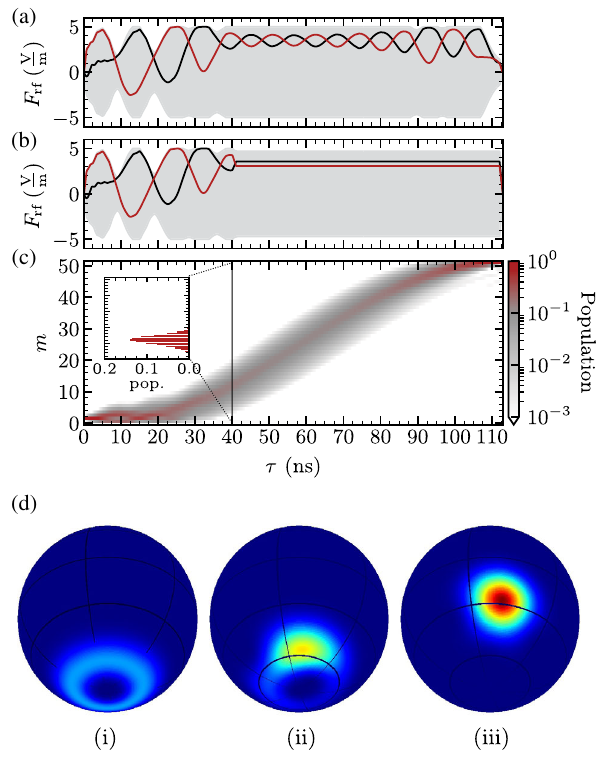
FIG. 4. Optimized circularization pulse. Amplitude of the two quadratures (red and black lines) of the optimized rf pulse (a) before and (b) after postprocessing (flattening of the oscillations that result from the constraint on the spectral bandwidth of the pulse). The gray area indicates the pulse envelope. (c) Evolution of the population of each Stark level of the lower diagonal as a function of time for the rf pulse of (b). The inset presents the histogram of the populations at τ ¼ 40 ns (red bars). (d) Snapshot of the Q function of the atomic state represented as a large angular momentum on a generalized Bloch sphere for τ ¼ 0 ns (i), τ ¼ 15 ns (ii), and τ ¼ 40 ns (iii). The first 40 ns of the pulse transfer the 52 m 2 level (i) into a spin coherent state